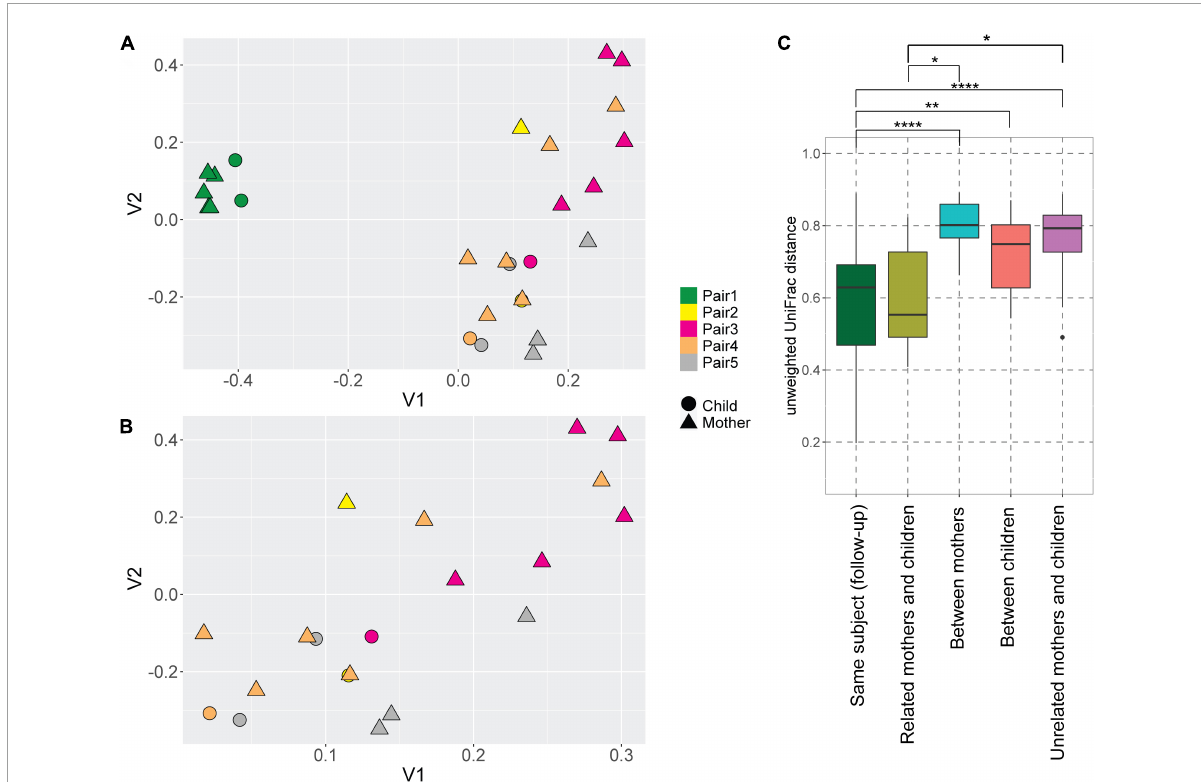
FIGURE3 UniFrac distances of the anellomes. Principal Component Analysis (PCoA) plot using unweighted UniFrac distances between all samples (A) and samples excluding pair #1 (B) . The colors represent different pairs, while the shapes represent the category of a sample (child or mother). (C) Unweighted UniFrac pairwise comparison between the longitudinal samples from the same subject, and related and unrelated samples (thus within or outside the pairs). To compare related and unrelated samples, only selected samples ( Supplementary Table 1 —samples marked with an asterisk) were used. Statistical significance was assessed using Wilcoxon sum-rank test. Only the significant values are marked on the graph; explanations of the symbols: * P ≤ 0.05, ** P ≤ 0.01, **** P ≤ 0.0001.